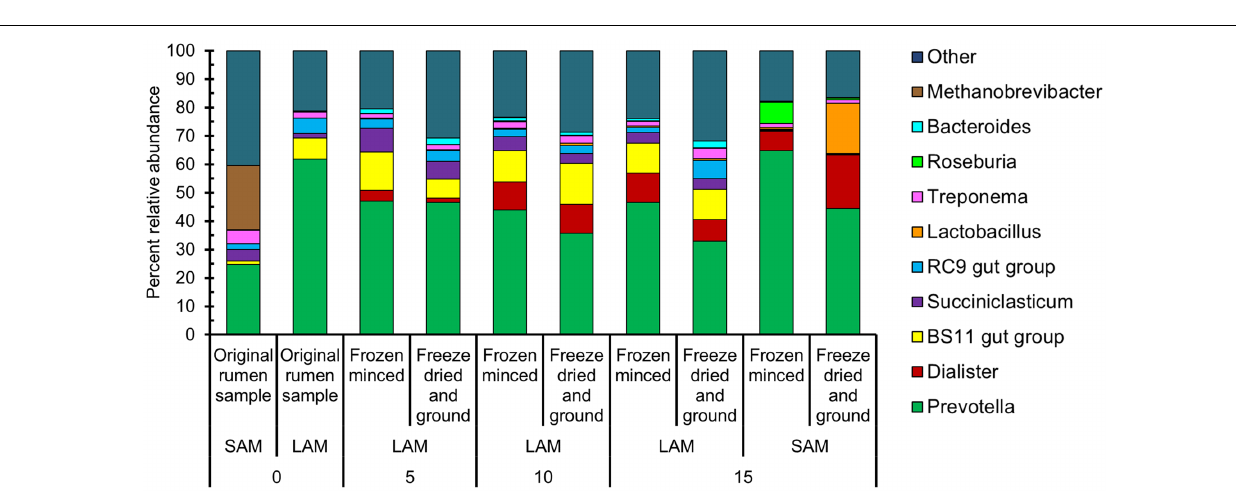
FIGURE 2 | The 10 most relatively abundant genera among all samples for each sample type, forage preparation type, and sampling day. LAM, liquid-associated microbes; SAM, solid-associated